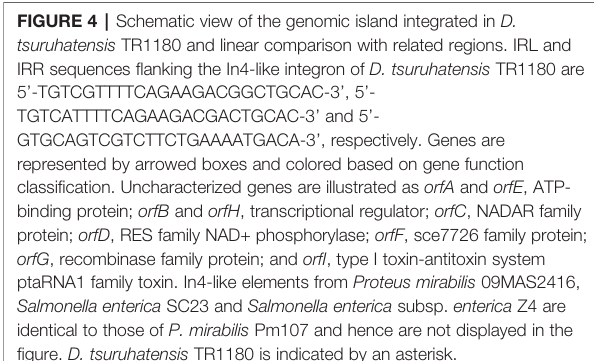
FIGURE 4 | Schematic view of the genomic island integrated in D. tsuruhatensis TR1180 and linear comparison with related regions. IRL and IRR sequences fl anking the In4-like integron of D. tsuruhatensis TR1180 are 5 ’ -TGTCGTTTTCAGAAGACGGCTGCAC-3 ’ , 5 ’ - TGTCATTTTCAGAAGACGACTGCAC-3 ’ and 5 ’ - GTGCAGTCGTCTTCTGAAAATGACA-3 ’ , respectively. Genes are represented by arrowed boxes and colored based on gene function classi fi cation. Uncharacterized genes are illustrated as orfA and orfE , ATP- binding protein; orfB and orfH , transcriptional regulator; orfC , NADAR family protein; orfD , RES family NAD+ phosphorylase; orfF , sce7726 family protein; orfG , recombinase family protein; and orfI , type I toxin-antitoxin system ptaRNA1 family toxin. In4-like elements from Proteus mirabilis 09MAS2416, Salmonella enterica SC23 and Salmonella enterica subsp. enterica Z4 are identical to those of P. mirabilis Pm107 and hence are not displayed in the fi gure. D. tsuruhatensis TR1180 is indicated by